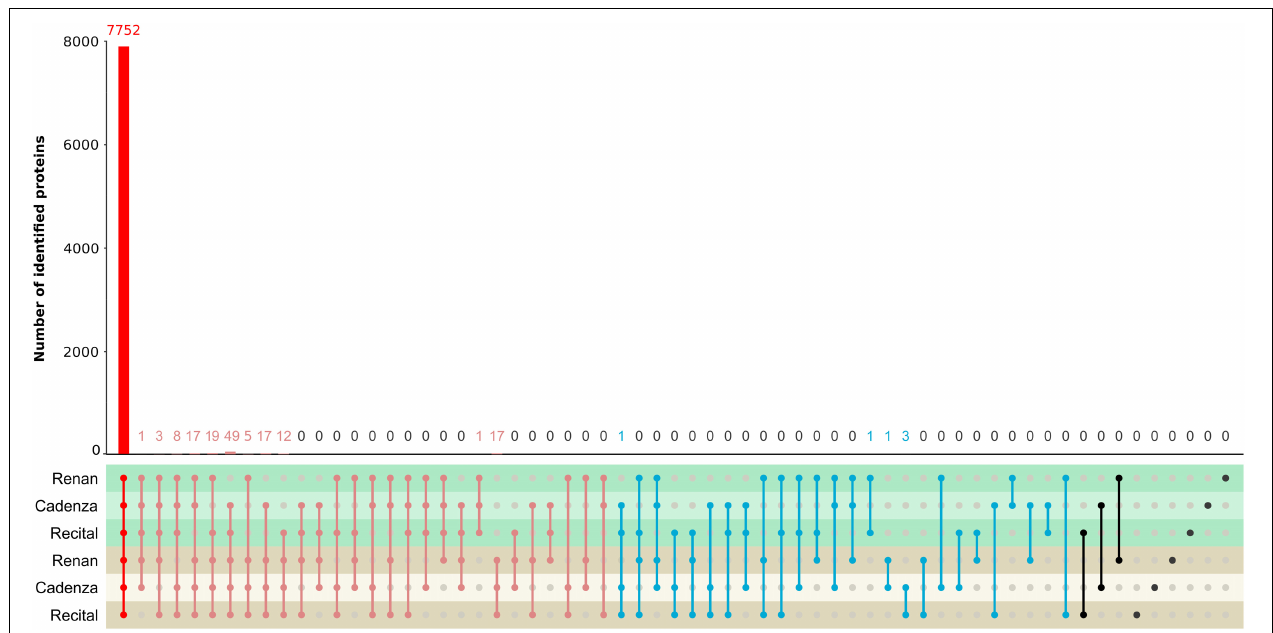
FIGURE 1 | Representation of the number of wheat proteins identified in the different samples. For each infected (in brown ) and control cultivar (in green ), the number of proteins identified in each sample combination is indicated in red color for the three wheat cultivars’ core proteome, in light red for the extended core proteome, in blue for the accessory proteome, and in black for the specific cultivar